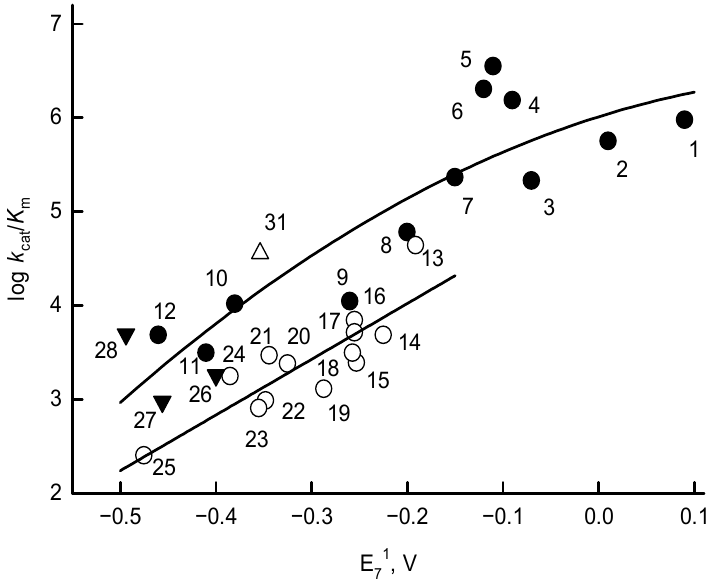
Figure 4. Dependence of the reactivity (log k cat / K m ) of quinones (solid circles), nitroaromatic compounds (blank circles), aromatic N -oxides (solid triangles), and benzylviologen (blank triangle) on their single-electron reduction midpoint potentials ( E 1 7 ). Numbers and reduction potentials of compounds are given in Table 1.